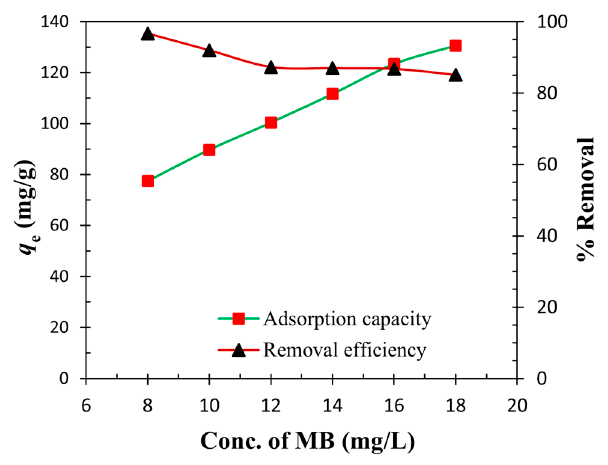
Figure 15. Effect of the initial concentration of MB on the adsorption process ( W rGO = 10 mg, V = 100 mL, T = 298 K).